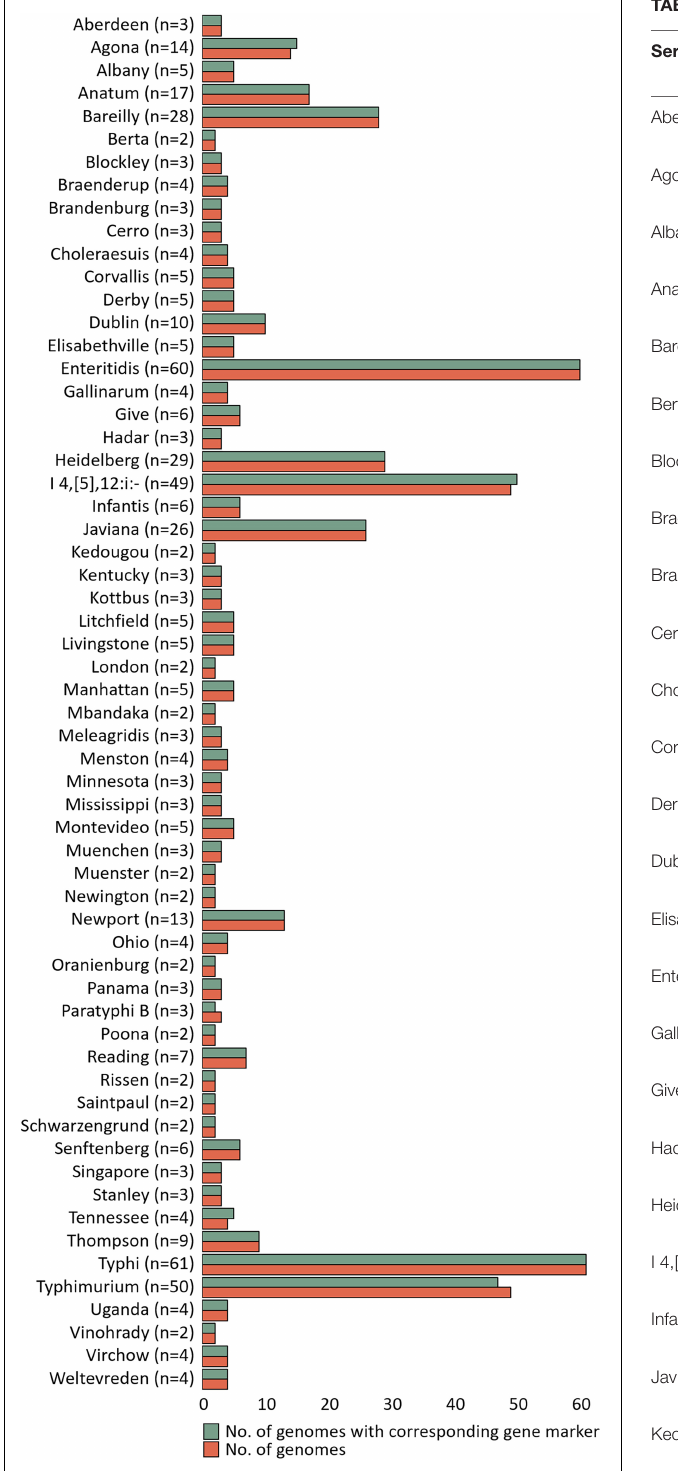
TABLE 3 | Sequences of serovar-specific primer pairs for real-time